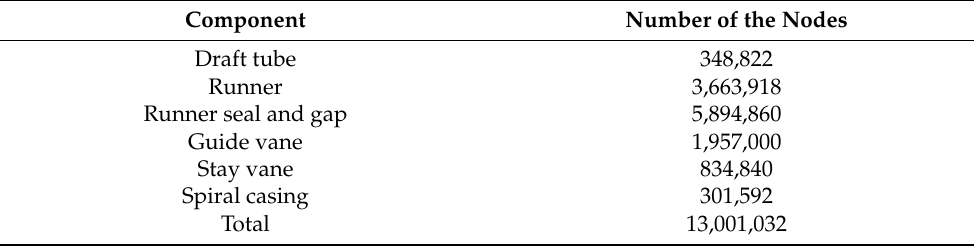
Figure 6. Pressure comparison of the critical positions between CFD and experiment. Table 2. Mesh node number of all the components.